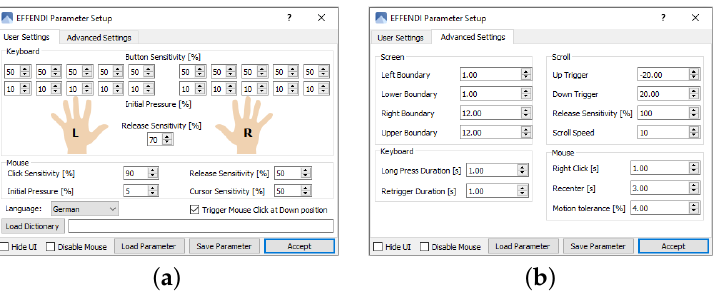
Figure 9. Setup window of the desktop application to load previously calibrated user data or perform manual changes. ( a ) User settings to adjust keyboard and mouse sensitivity. ( b ) Advanced settings to further customize user